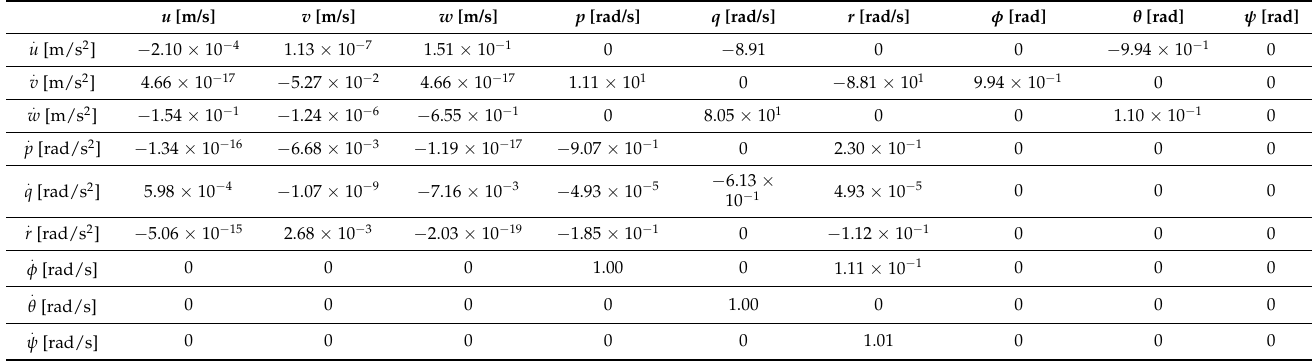
Table 6. Complete 9 × 9 stability matrix for case 1a in Table 3.